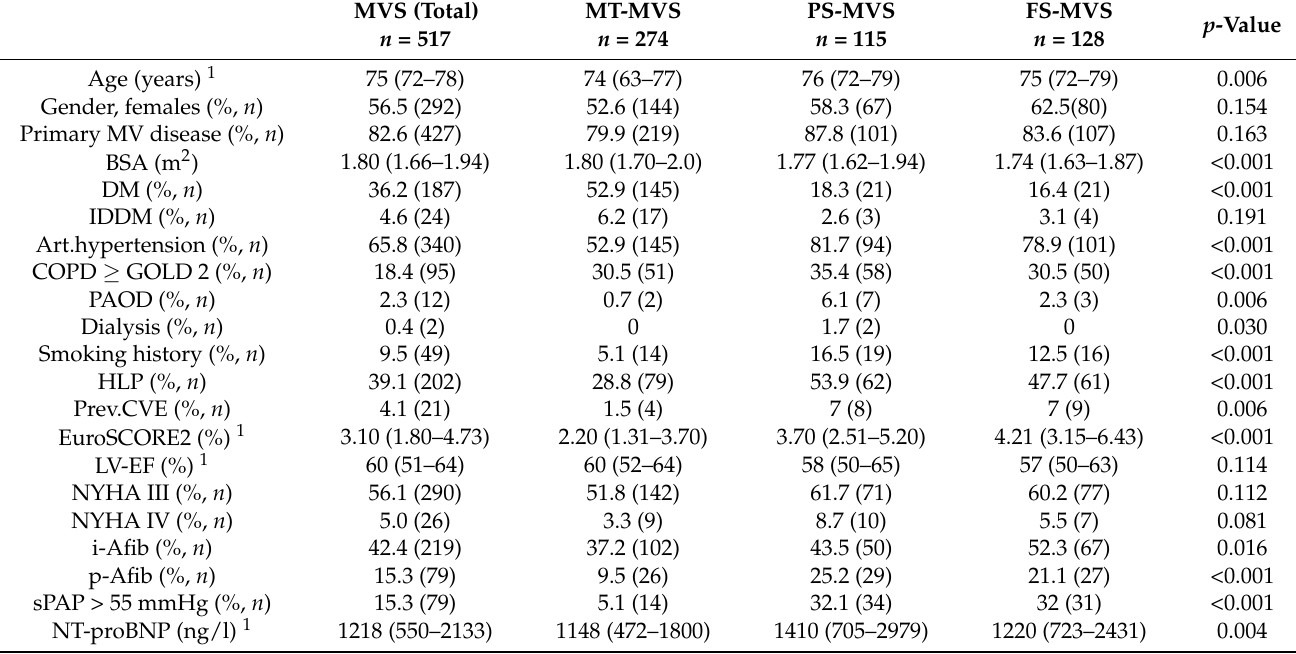
Table 2. Baseline characteristics of the study